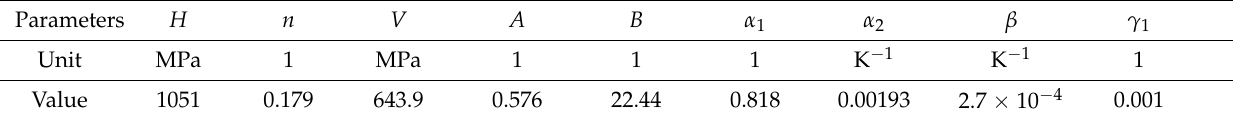
Table 4. Parameters of the SKW model for DP590 steel ( T m = 1750 K) [13].